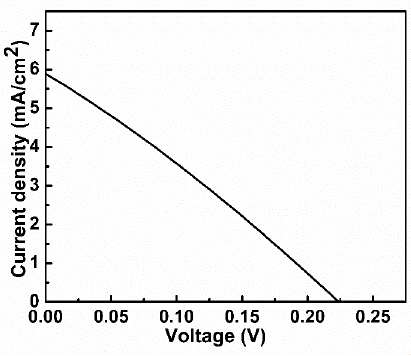
Figure 6. Schematic of the CZTS solar cell fabrication process.